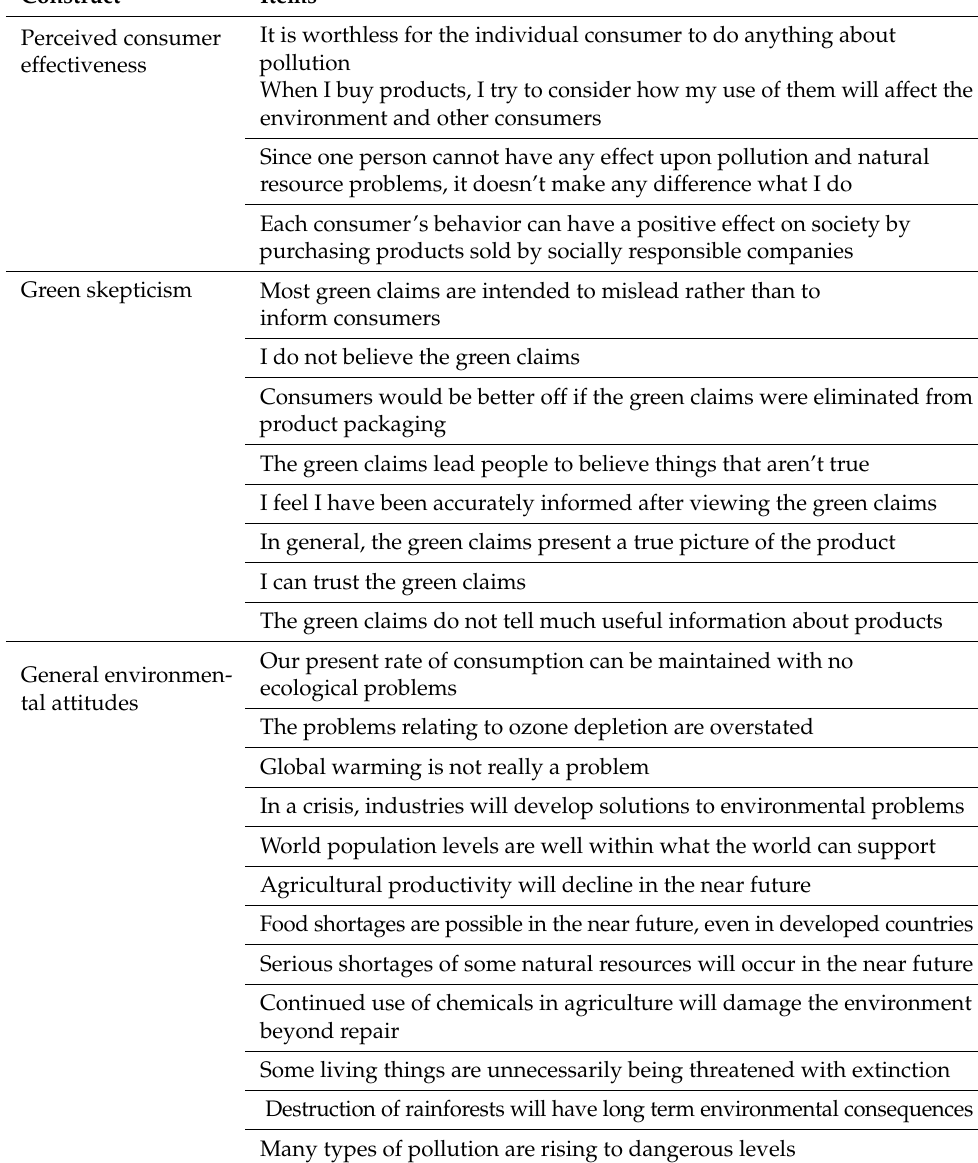
Table A1. List of items per